Question: In a single sentence, describe what this figure presents.
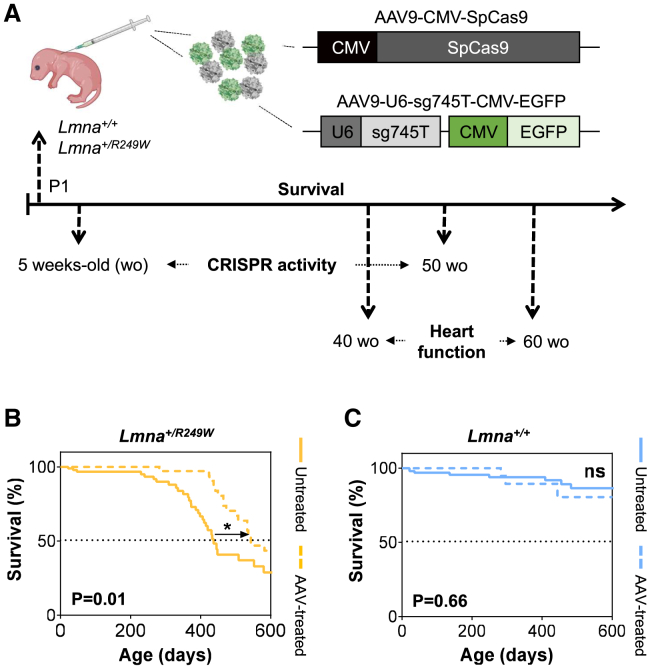
Answer: AAV9-Cas9/sg745T treatment increases survival in Lmna +/R249W mice (A) Schematic experimental design to evaluate the survival and cardiac function after intradermal administration of AAV9-Cas9/sg745T treatment. AAV9-Cas/sg745T was injected into 1-day-old Lmna +/R249W and Lmna +/+ mice. Control mice received no treatment. (B) Kaplan-Meier survival curve of untreated ( n = 100) and AAV-treated ( n = 36) Lmna +/R249W mice. (C) Kaplan-Meier survival curve of untreated ( n = 100) and AAV-treated ( n = 26) Lmna +/+ mice. ns, non-significant differences; ∗ p < 0.05.